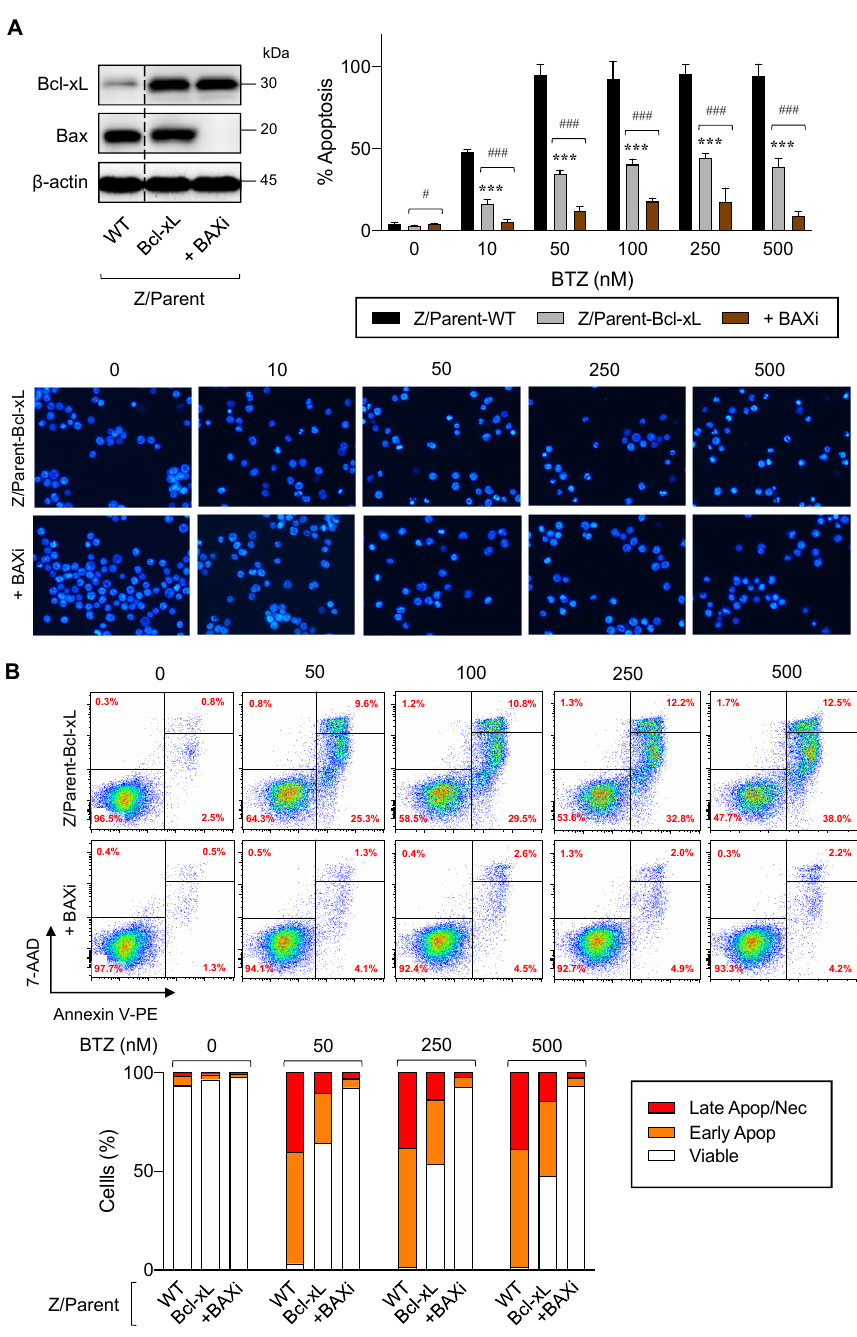
Figure 8. Overexpression of Bcl-xL and depletion of Bax cooperatively induces acquired BTZ resistance in MCL cells. Bcl-xL-overexpressed Z-138 cells were transduced with lentiviral particles carrying Cas9 and sgRNA against human BAX (Z/Parent-Bcl-XL + BAXi) or control particles (Z/Parent-Bcl-xL) and treated with BTZ (0–500 nM) for 24 h. ( A ) Upper left : Western blot analysis of Bcl-xL and Bax levels in Z/Parent-Bcl-xL + BAXi and Z/Parent-Bcl-xL cells in comparison to the parental Z/Parent-WT cells prior to experiments. The dashed line separates juxtaposed lanes taken from the same experiment and blot image. Upper right : Percentages of apoptosis as evaluated by Hoechst 33342 assay were scored and plotted. Data are mean ± SD ( n = 3). *** p < 0.001 versus Z/Parent-WT cells; # p < 0.05, ### p < 0.001 versus Z/Parent-Bcl-xL cells; two-sided Student’s t -test. Lower : Representative micrographs of Hoechst 33342 nuclear staining under an inverted fluorescence microscope. ( B ) Analysis of cell death by Annexin V/7-AAD assay. Percentages of Annexin V single-positive cells defining early apoptosis, and Annexin